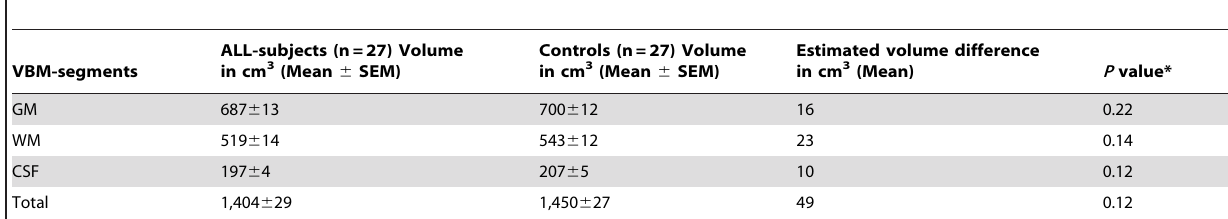
Table 3. Results of statistical comparison of the absolute volumes of GM, WM and CSF as well as the total brain volume computed with